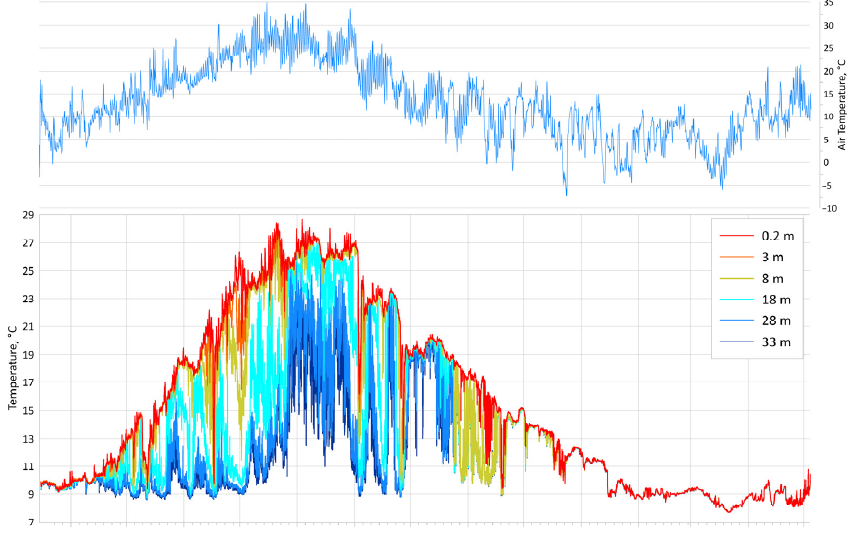
Figure 6. Water temperature according to the data of the thermistor chain from 15 March to 4 May 2022—bottom panel. Air temperature according to the Anapa weather station data—upper panel. The thermistor chain sank to the bottom after 25 October 2021.